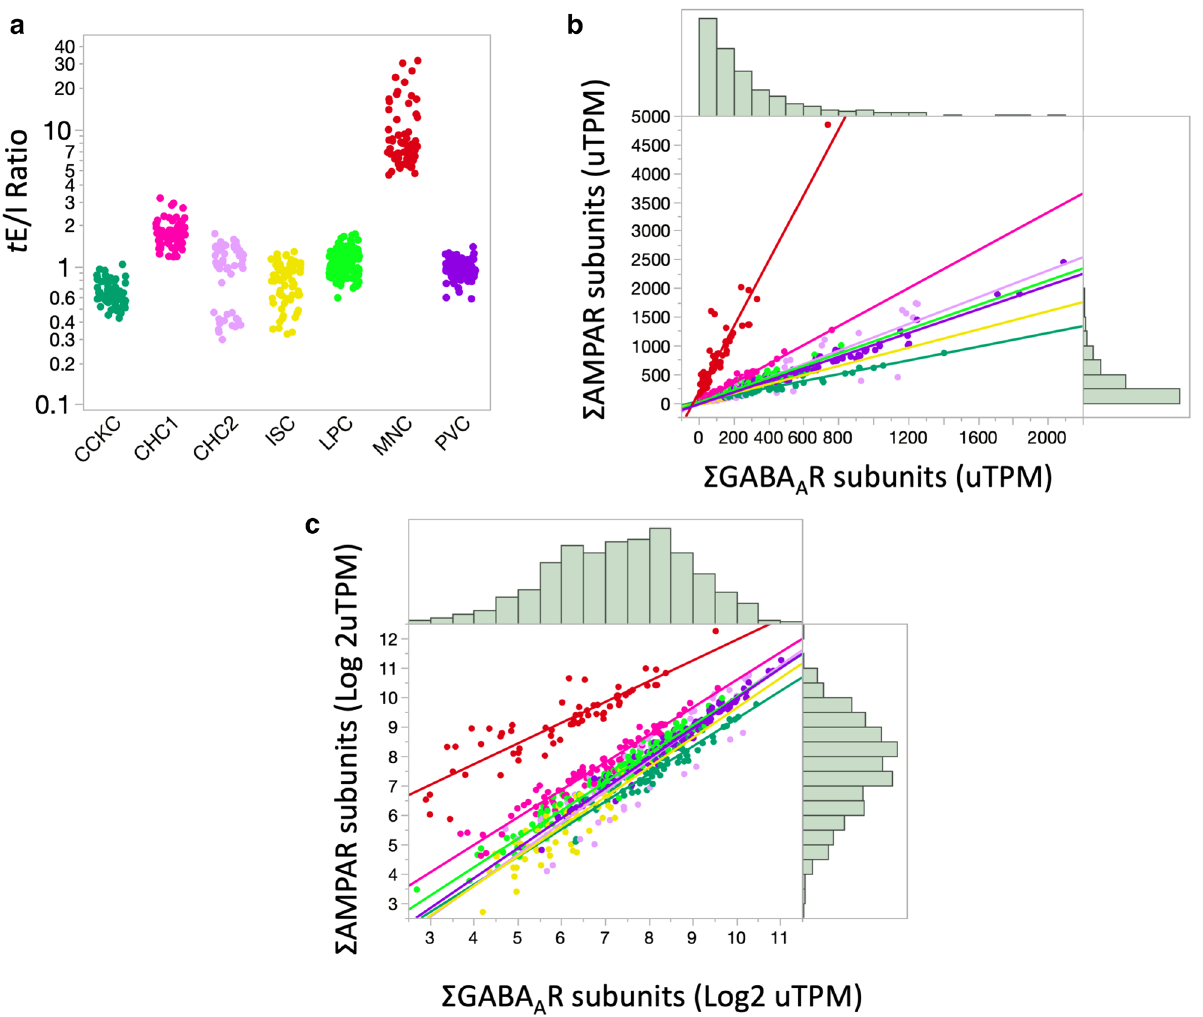
Figure 5. Cell-type differences in transcriptional E/I ratio in the mouse brain. ( a ) Transcriptional E/I ratio of phenotypically identified GABAergic cell-type 35 . Ratios were plotted on a logarithmic scale. Each point represents a single cell nucleus analyzed. ( b , c ) Plotting of total AMPARs expression against total GABA A Rs subunits expression using normalized data as downloaded ( b ) or after Log2 transformation to normalize the distribution ( c ). Continuous lines show significant Pearson correlations for all cell-types ( p < 0.001). Histograms represent the data distribution for the cohort in either